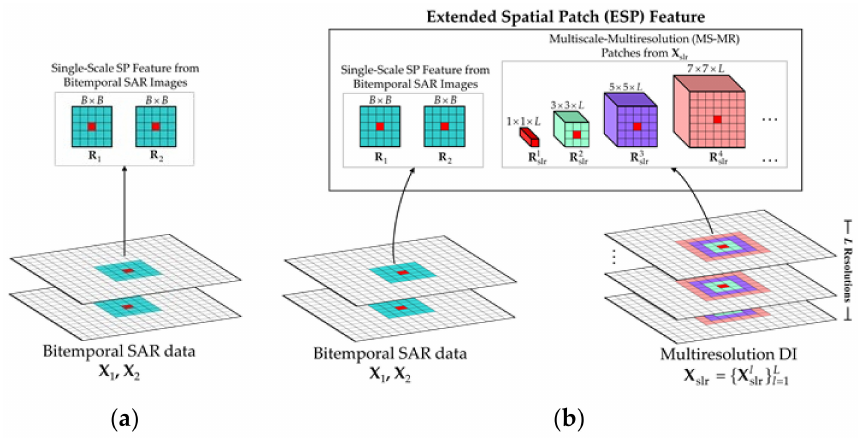
Figure 3. Schematic of ( a ) SP feature generation and ( b ) ESP feature